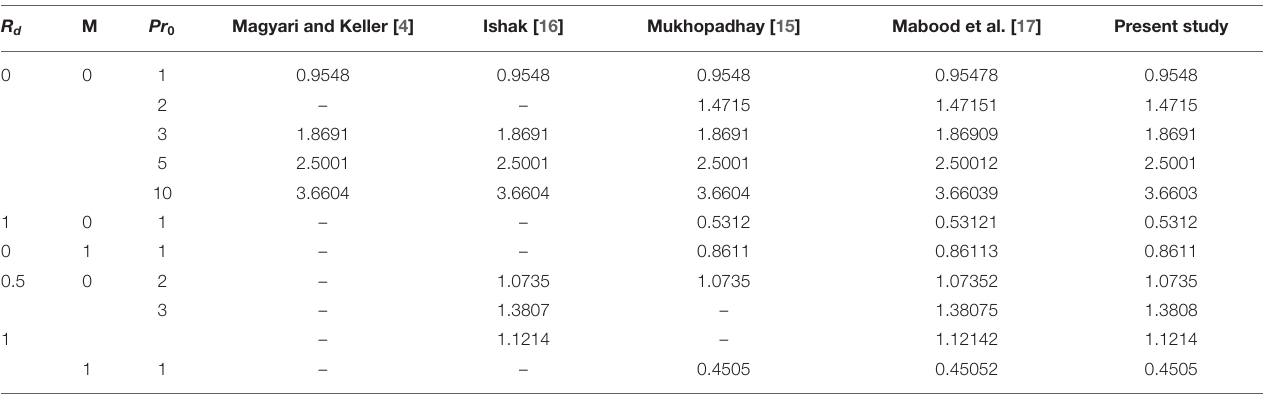
TABLE 2 | ( For Case B ) Comparison of the values of f ′′ (0), θ ′ (0) and φ ′ (0) for different values of ǫ and λ when M